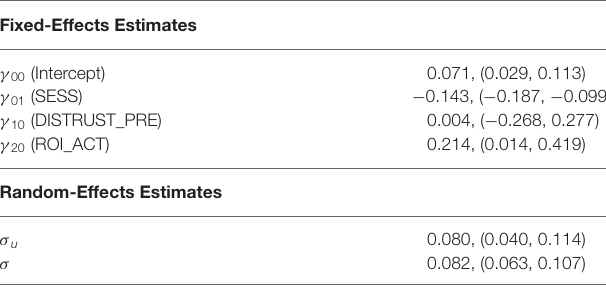
TABLE 2 | Fixed- and random-effects estimates for Model 1